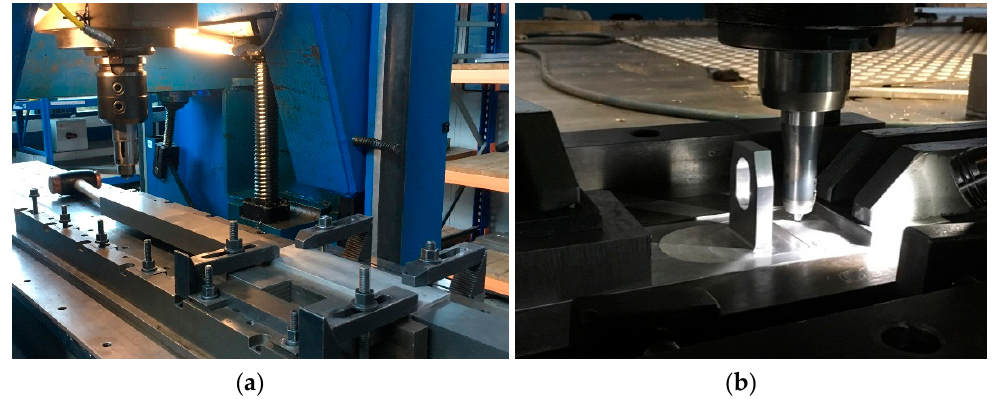
Figure 6. Different welds performed. ( a ) Longitudinal weld, ( b ) bracket weld. Samples of the longitudinal and bracket welds were transversally cut and polished with emery paper from grits 400 to 3000, followed by micro-diamond polish and Keller etching to evaluate the tool’s penetration and possible discontinuities using the European norm “Friction stir welding—Aluminium (ISO 2523)” as guide [26–30]. Microhardness data were acquired using an Indenter ZHµ machine, set to 300 g and 10 s per sample, lo- cating the horizontal line at 300 µm from the top of the weld to obtain a value comparable with the base metal. Finally, for the economic evaluation, a comparison between the manufacturing costs and material prices was considered using FSW against the acquisition of pieces by MdM, to provide a baseline cost for local implementation. 3. Results 3.1. C-Shaped Weld The results for each weld trial configuration (upwards and downwards against the anvil, as shown previously in Figure 5) are presented in Figure 7. All the welds had a similar appearance without any visual or significant underfill of the joint due to excessive tool penetration compared with the base metal, meaning that the parameters chosen were correct and in accordance with the quality control and TWI’s experience. ( a ) ( b ) Figure 7. Preliminary “ C ” joints. ( a ) Downwards configuration and ( b ) upwards configuration.